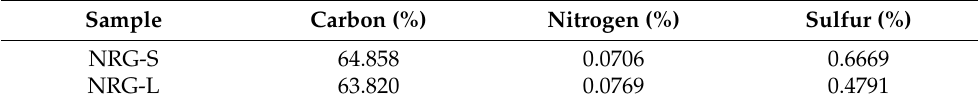
Table 1. Composition of waste NRG from CNS analysis.